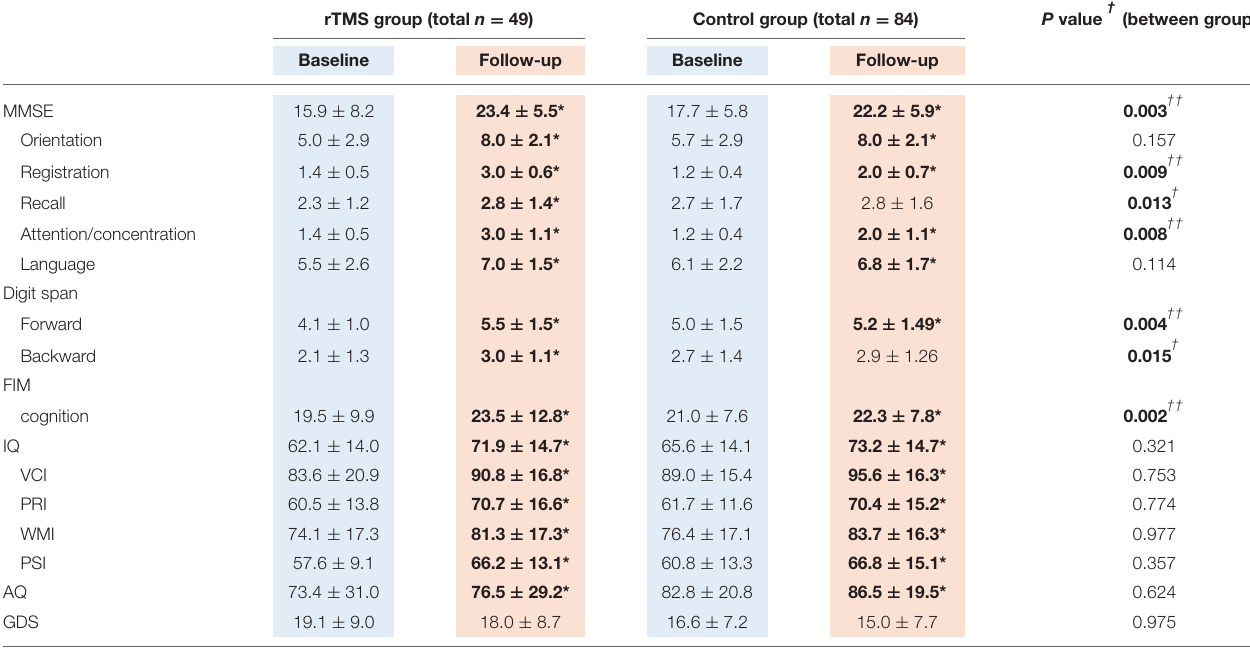
TABLE 4 | Comparison of rehabilitation outcomes between rTMS and control groups (right hemispheric stroke subjects, N =